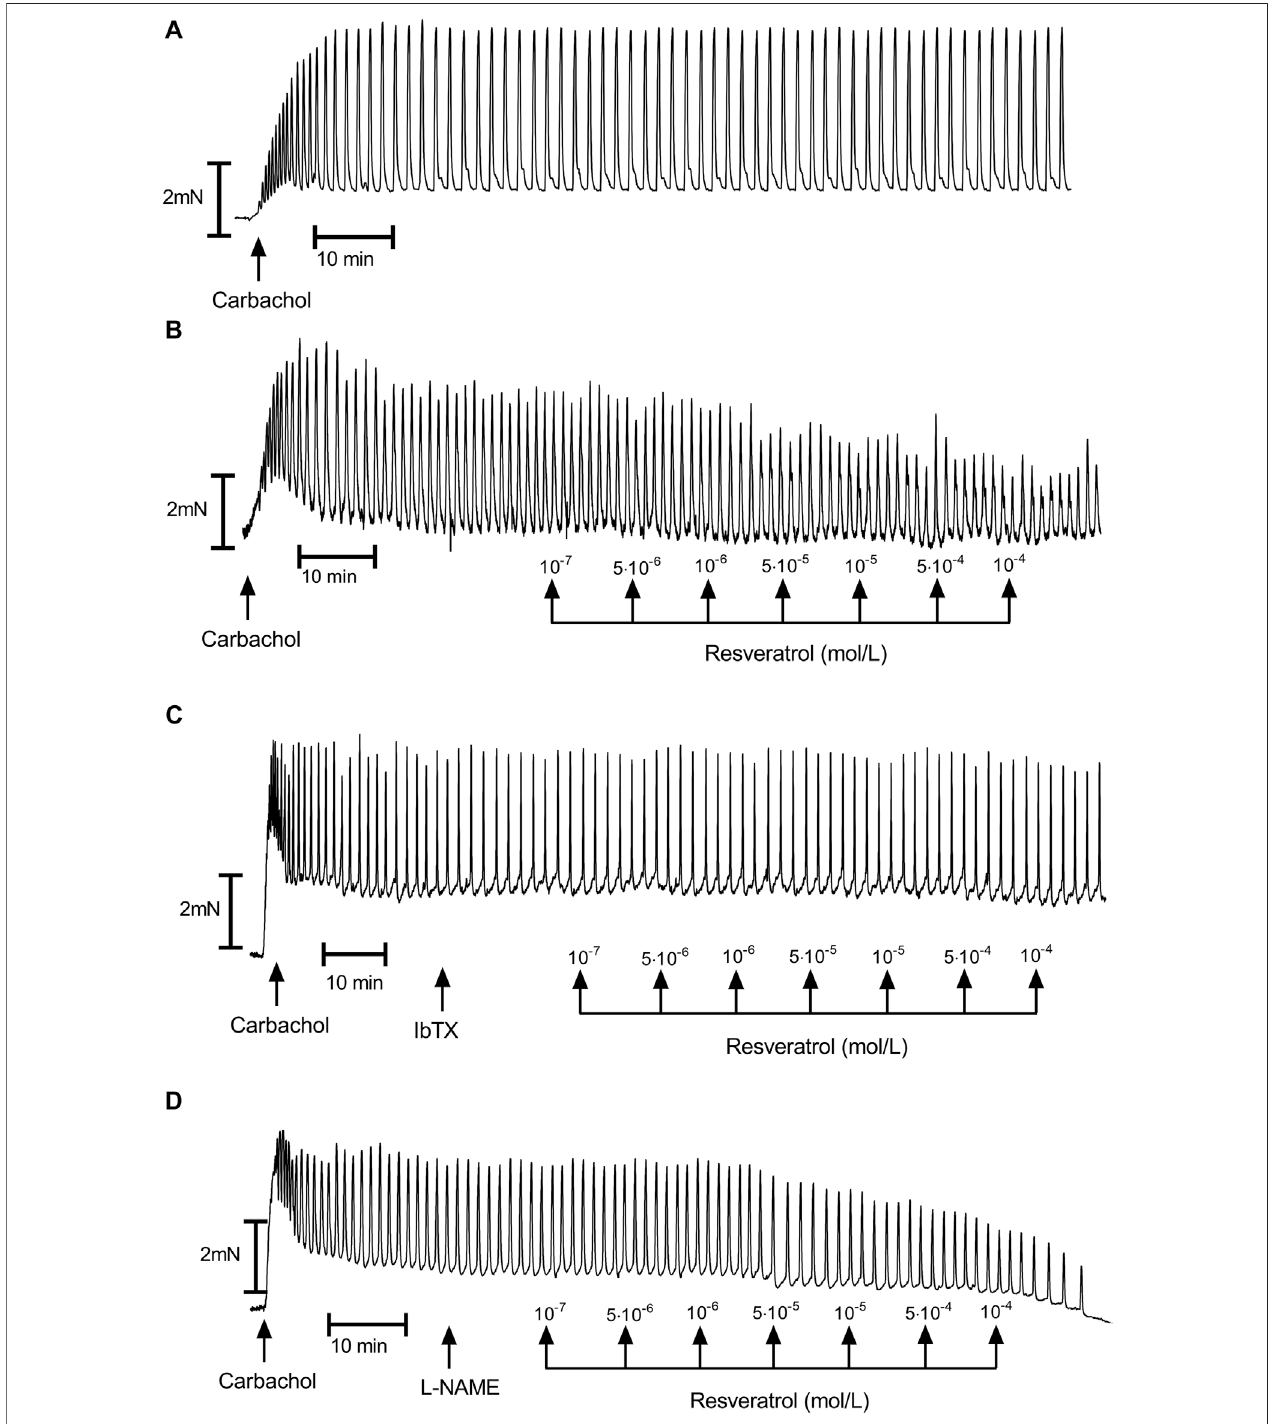
FIGURE 2 | A representative tracings of carbachol-induced gastric muscle contractions. (A) — control; (B) — resveratrol (range 10 – 7 – 10 – 4 mol/L); (C) — resveratrol (range 10 – 7 – 10 – 4 mol/L) after preincubation with iberiotoxin (10 – 7 mol/L); (D) — resveratrol (range 10 – 7 – 10 – 4 mol/L) after preincubation with L-NAME (10 – 6 mol/L).